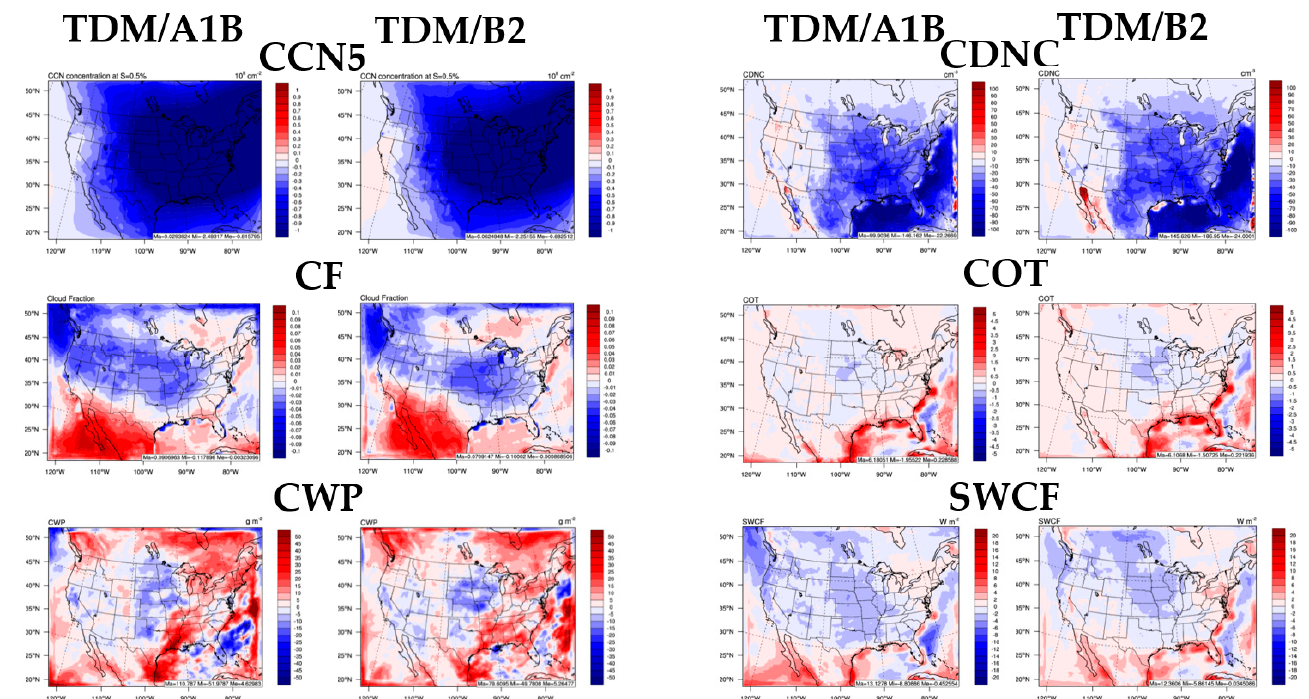
Figure 7. Absolute changes of annual average cloud condensation nuclei at supersaturation 0.5% (CCN5), cloud droplet number concentration (CDNC), cloud fraction (CF), cloud optical thickness (COT), cloud water path (CWP), and shortwave cloud forcing (SWCF) between the future and current decade for TDM/A1B and TDM/B2.